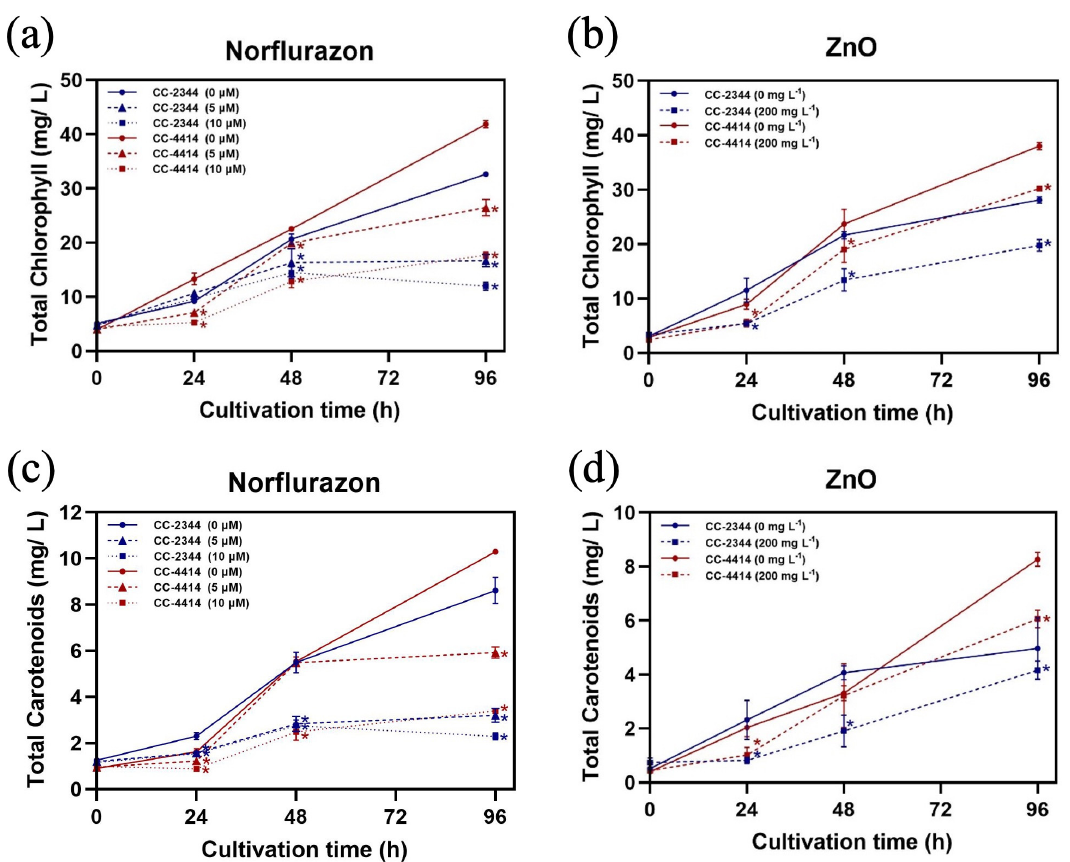
Figure 6. Pigment production. Chlorophyll content ( a , b ) and carotenoid content ( c , d ) under norflurazon and ZnO NP conditions, respectively. Blue and red solid lines are CC − 2344 and CC − 4414 with no chemicals, respectively. Blue and red dashed lines and dotted lines represent CC − 2344 and CC − 4414 with the indicated concentration of the chemical, respectively. All data are means ± SD of three biological replicates. Significant differences between the control culture and the chemical-added culture within the same condition are indicated by asterisks (*) ( p < 0.05).